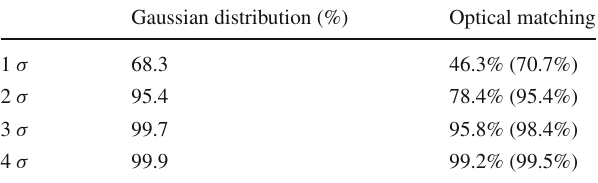
Table 5 Comparison of the electron distribution after non linear beam– beam interaction. The values represent the density of electrons for sev- eral rms emittance areas for the design optics as well as for the fitted ellipse of the post-collision distribution, in parenthesis